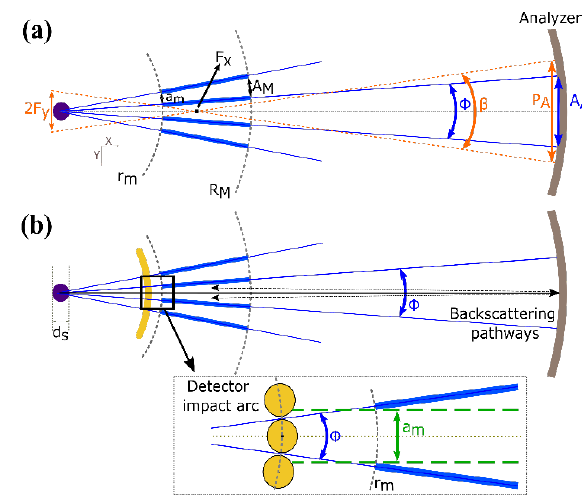
Fig. 5. (a) Schematic representation of forward scattered neutrons passing through a single slit of the collimator and arriving to the analyzer. (b) Schematic representation of backscattered neutrons arriving to the detector array (green dashed lines) define the detector impact arc a